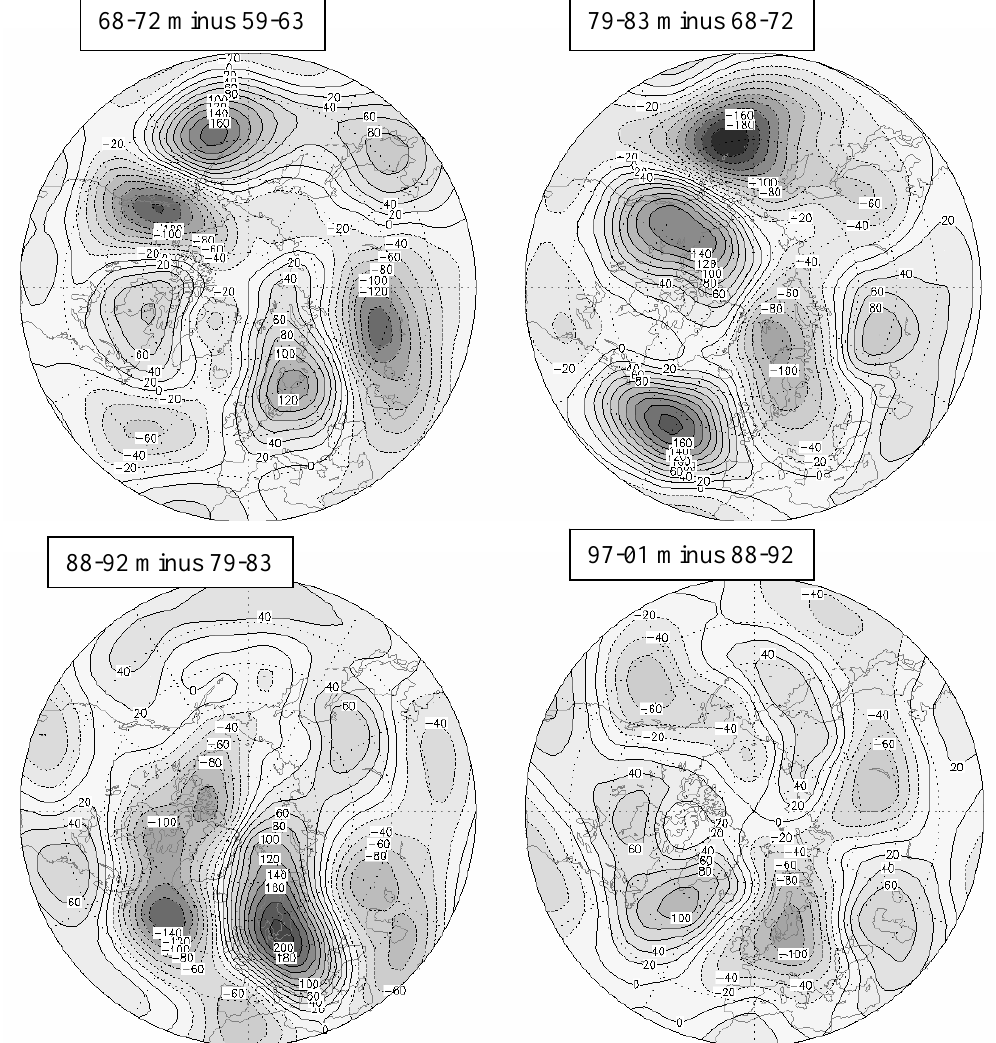
Fig. 4. Decadal January differences of 5-year averages of mean geopotential height perturbations (end minus beginning of the decade) (m) Figure 4: Decadal January differences of 5 year averages of mean geopotential height at the 300-hPa perturbations (end minus beginning of the decade) (m) at 300 hPa layer.